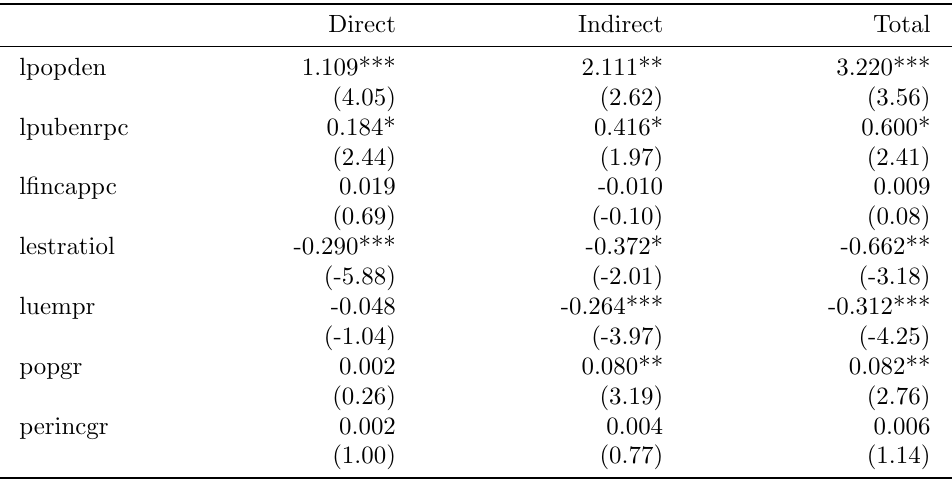
Table 5: Estimated direct, indirect, and total